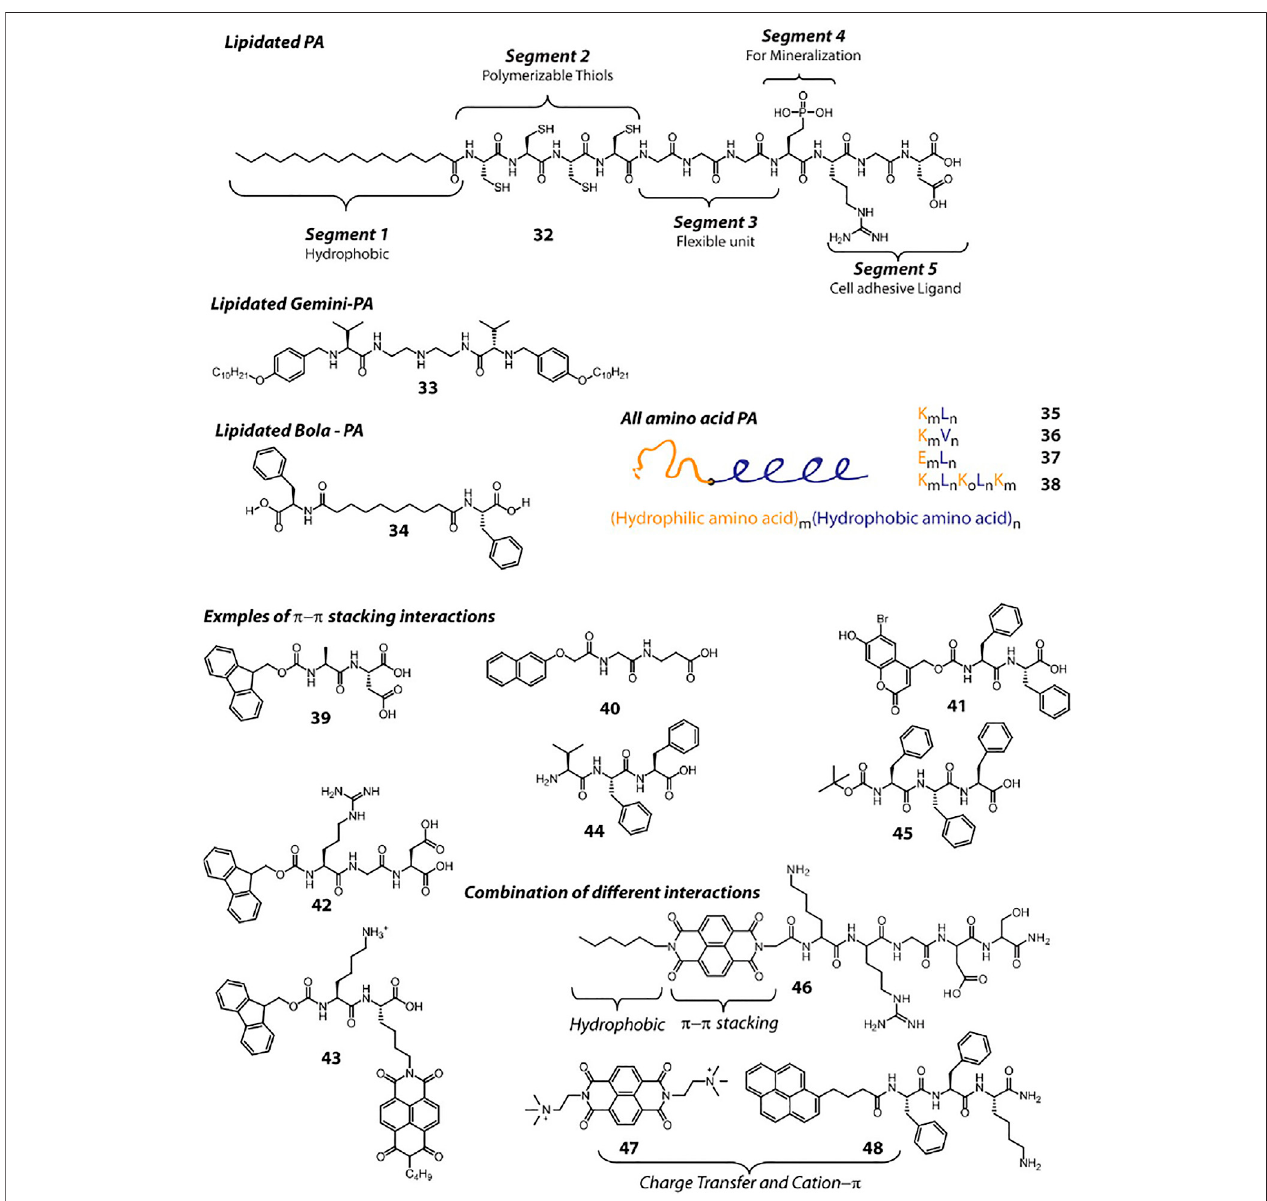
FIGURE 3 | Chemical structures and sequences of representative peptide hydrogelators classi fi ed according to the supramolecular interactions involved in their self-assembly.